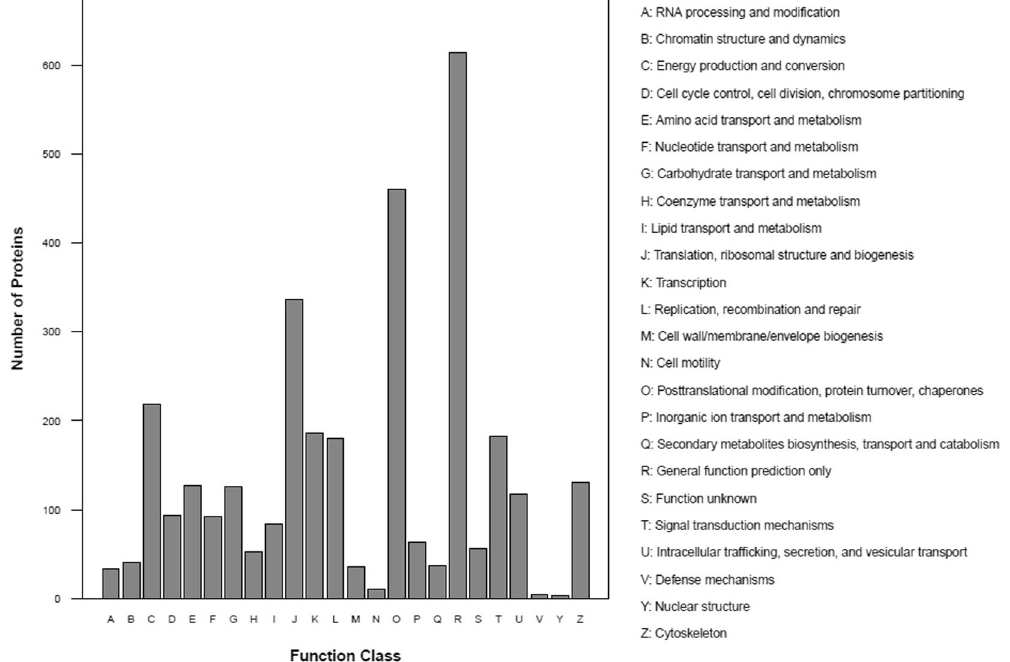
Figure 3. COG classification of all detected proteins in the CM of